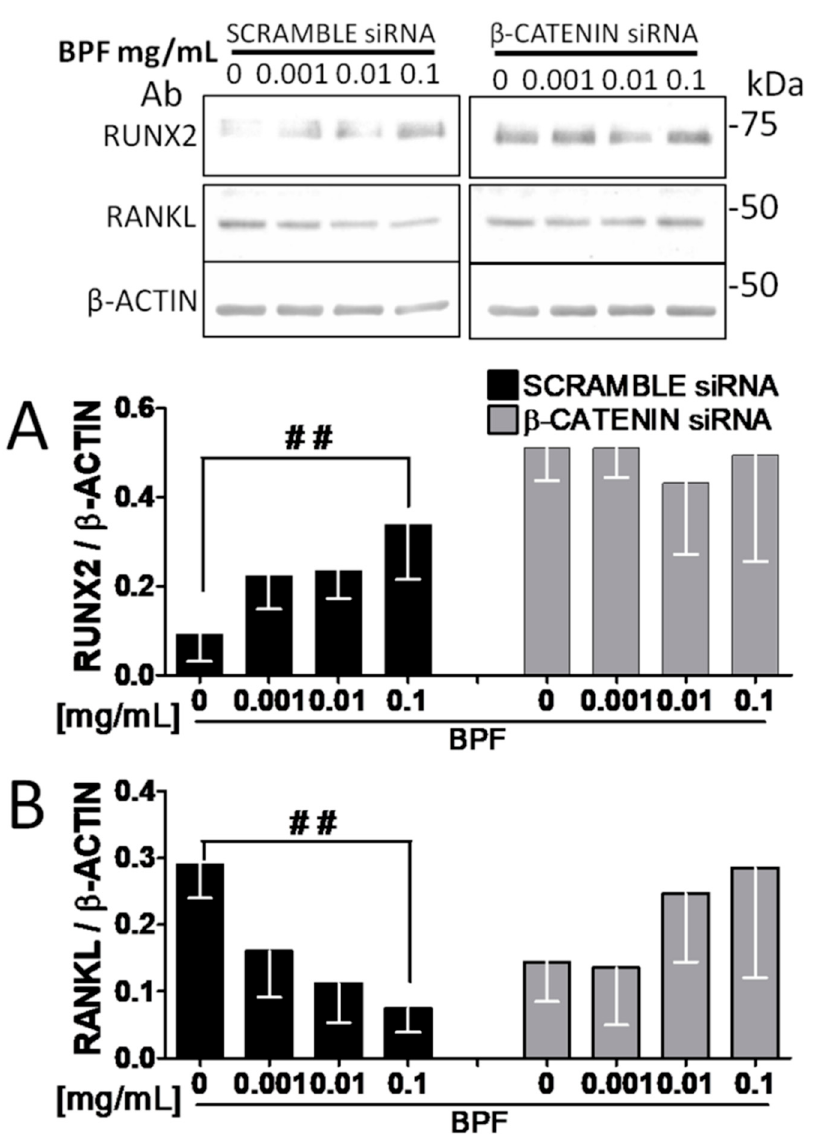
Figure 6. Reverted effects on both the RUNX2 and RANK-L protein expression with BPFon β -catenin knockdown Saos-2 cells. Semi-confluent cultures of human osteoblast-like cells (Saos-2) were pretreated with scrambled or β -catenin siRNA for 48 h, then incubated with BPF 0.001-0.01-0.1 mg/mL for 24 h. Cell proteins were analyzed by Western blotting, with antibodies specific to ( A ) RUNX2, ( B ) RANKL and β -actin. Data are represented as mean ± SD. Statistical analysis: Linear regression; ## p < 0.01. Abbreviations: BPF, Bergamot Polyphenol Fraction; RUNX2, Runt-related transcription factor 2; RANKL, Receptor Activator of Nuclear factor- κ B Ligand.